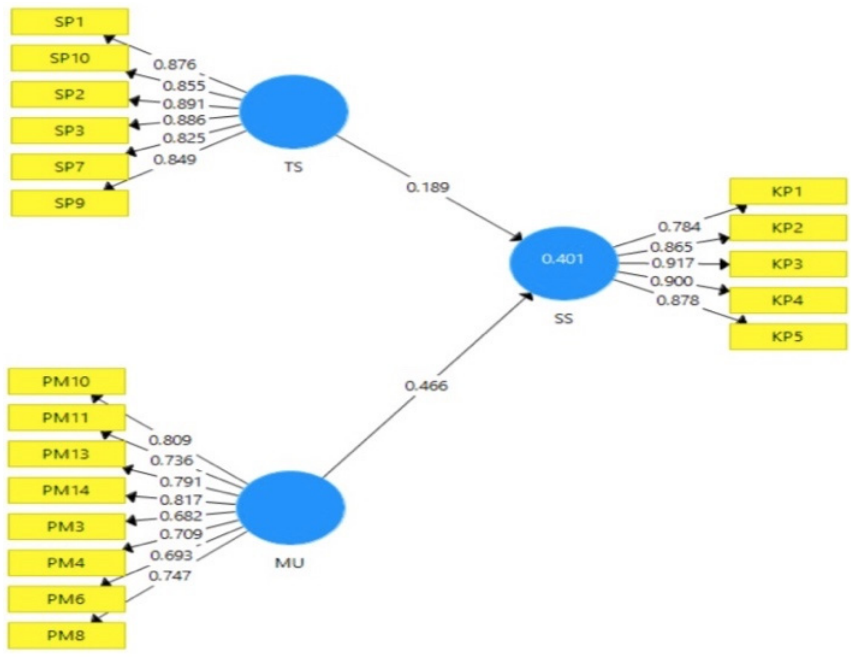
Figure 1. Reflective Measurement Model. (TS: Teaching Strategies; MU: Multimedia Usage; SS: Student Satisfaction).